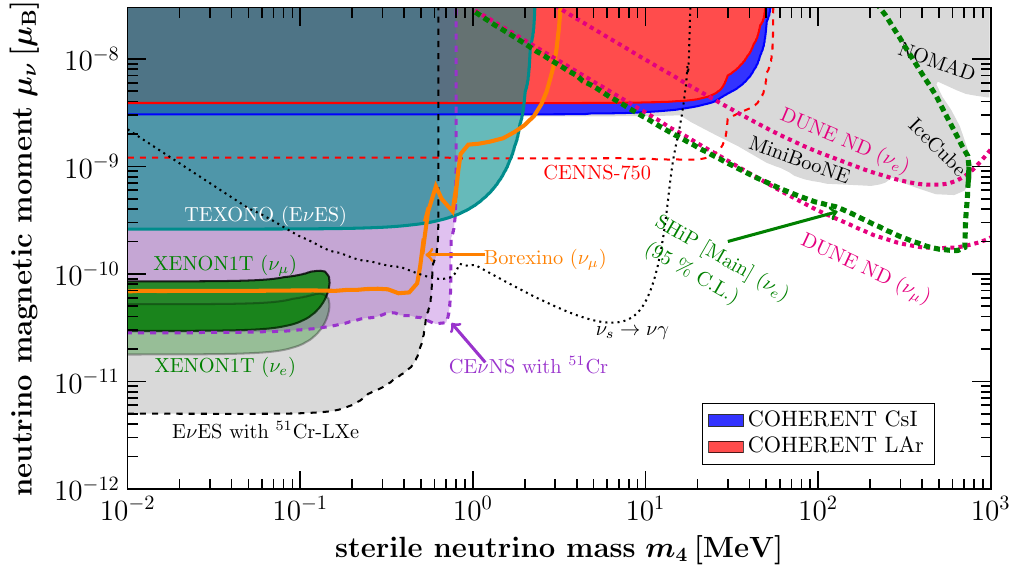
Figure 3 . Sensitivity of CE ν NS and E ν ES experiments to the effective sterile neutrino transi- tion magnetic moments. Relevant limits from other experiments are shown for comparison. Solid (dashed) lines correspond to current (future) experiments (see